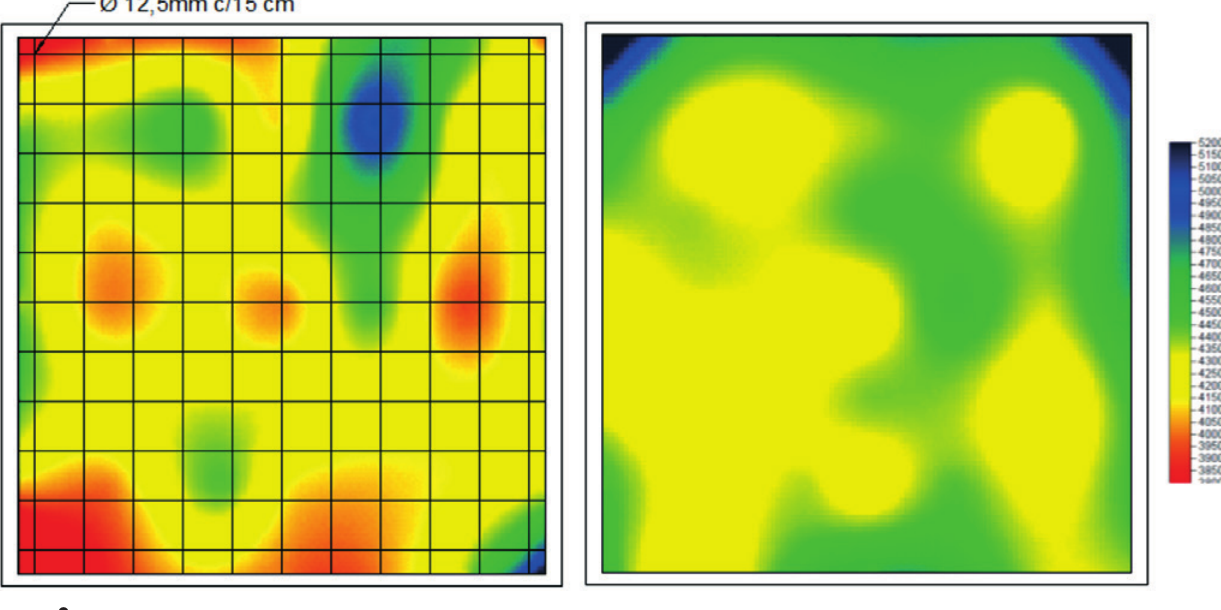
(a) images generated on the wall with reinforcement (b) images generated on the wall without